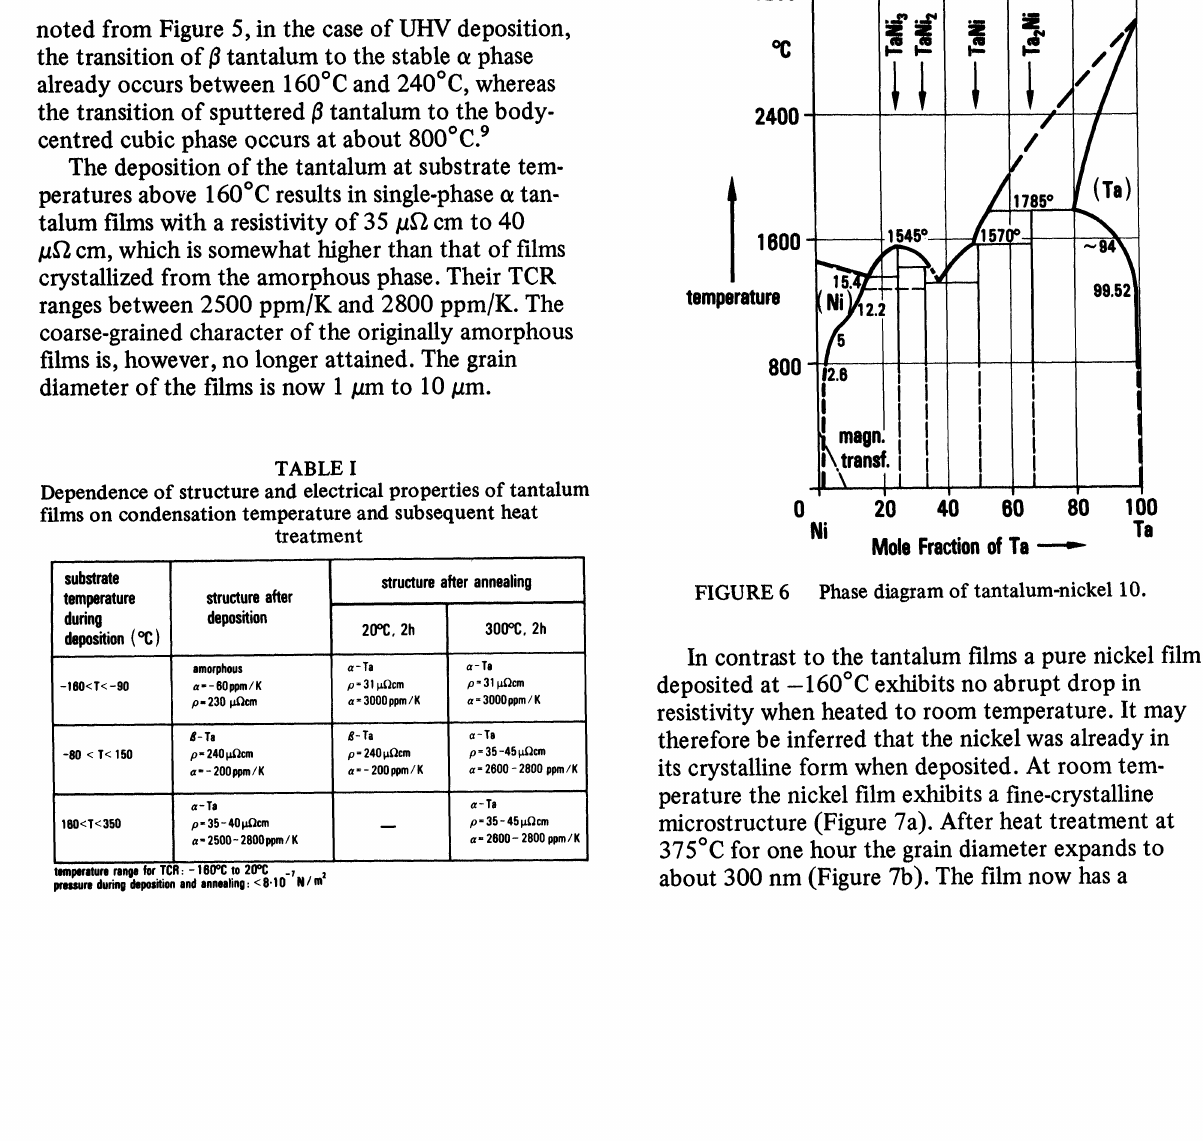
Resistivity p versus temperature of a tantalum film deposited at 20 C.